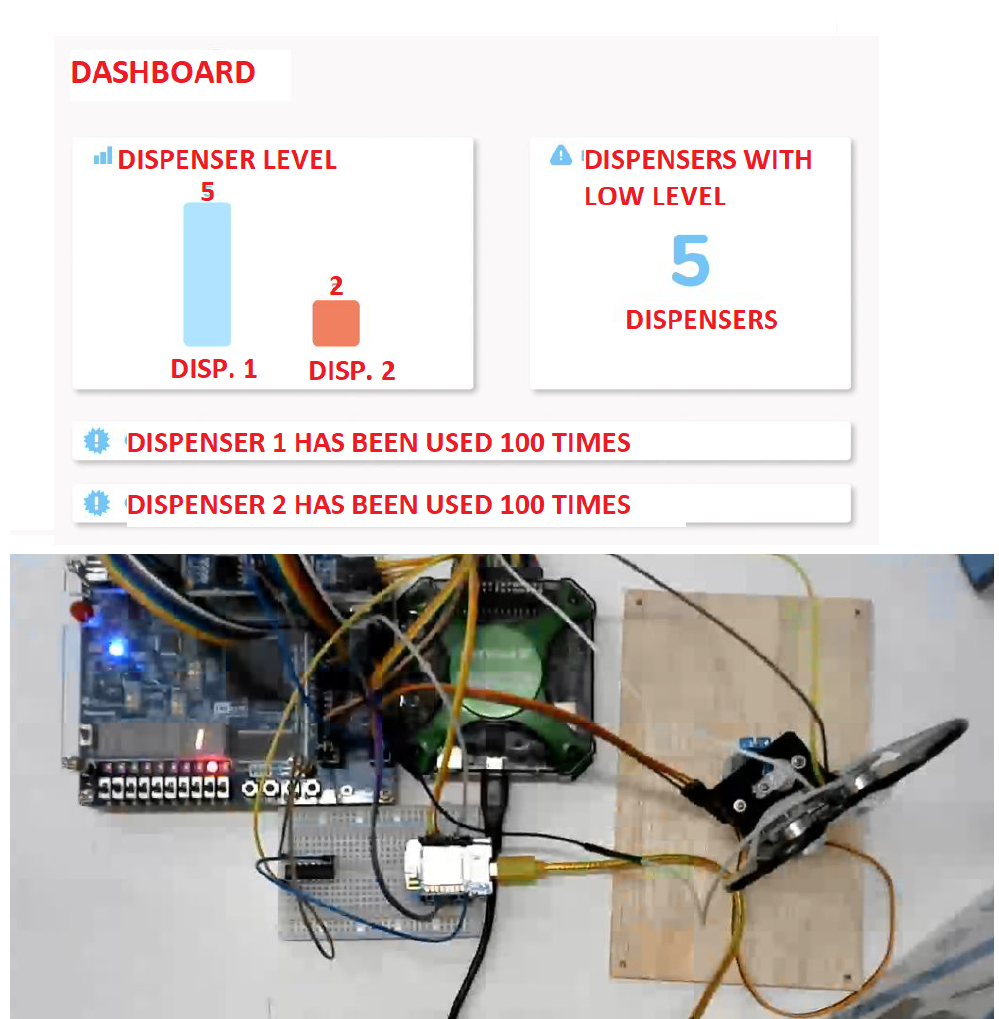
Figure 6. Automatic Gel Dispenser